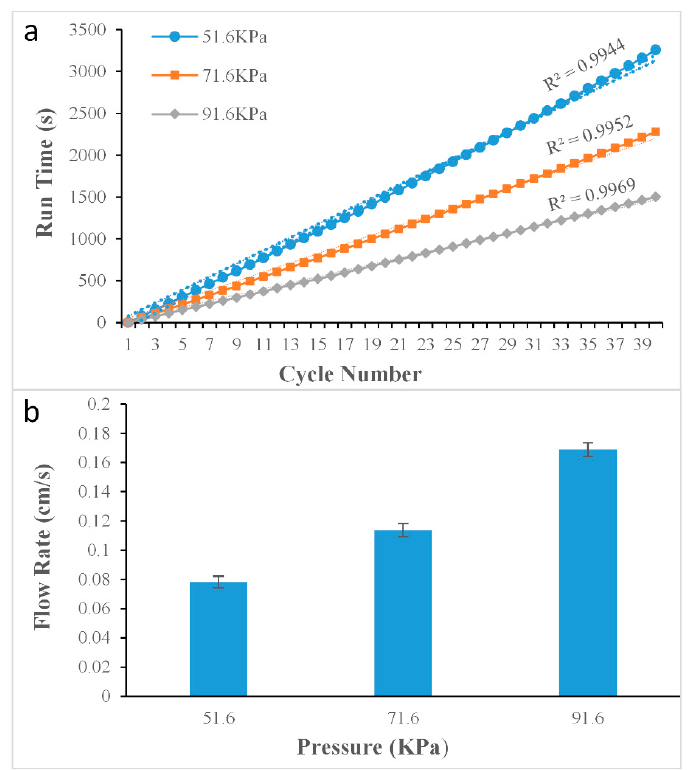
Figure 4. Results of experiment on changing pressure of the syringe. ( a ) Flow time under different pressure; ( b ) flow velocity under different pressure.